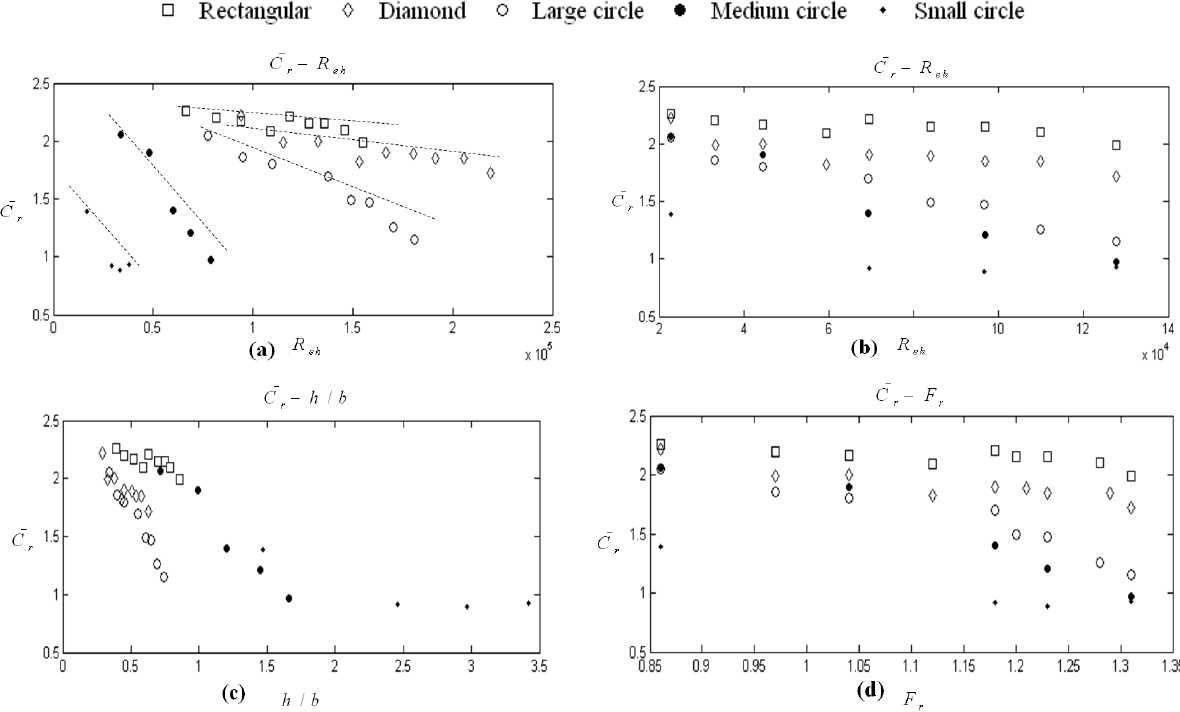
(output) with relevant inputs. r